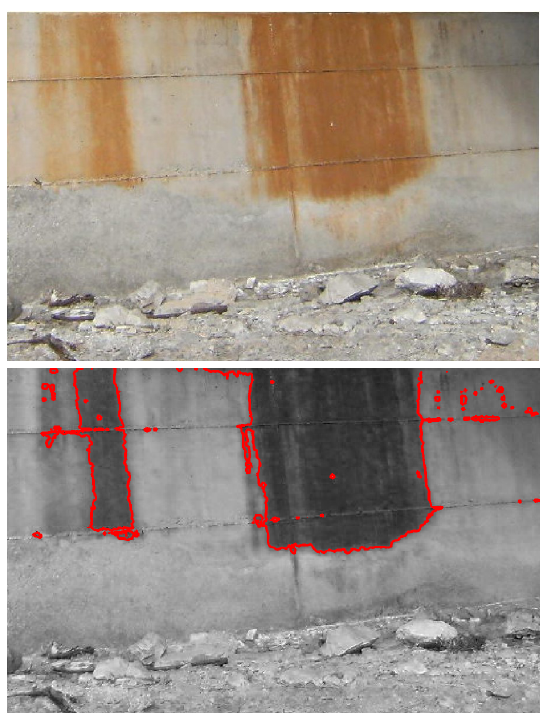
Figure 9: Top: original image. Bottom: example of segmentation results.